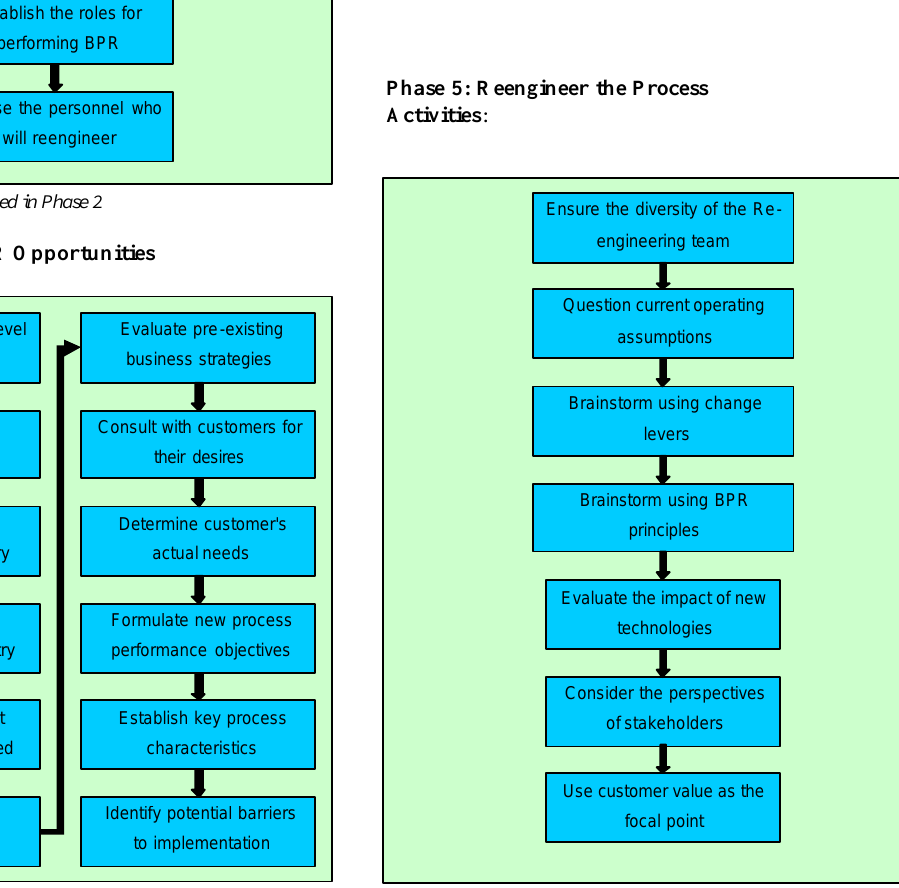
Figure 5: Activities Performed in Phase